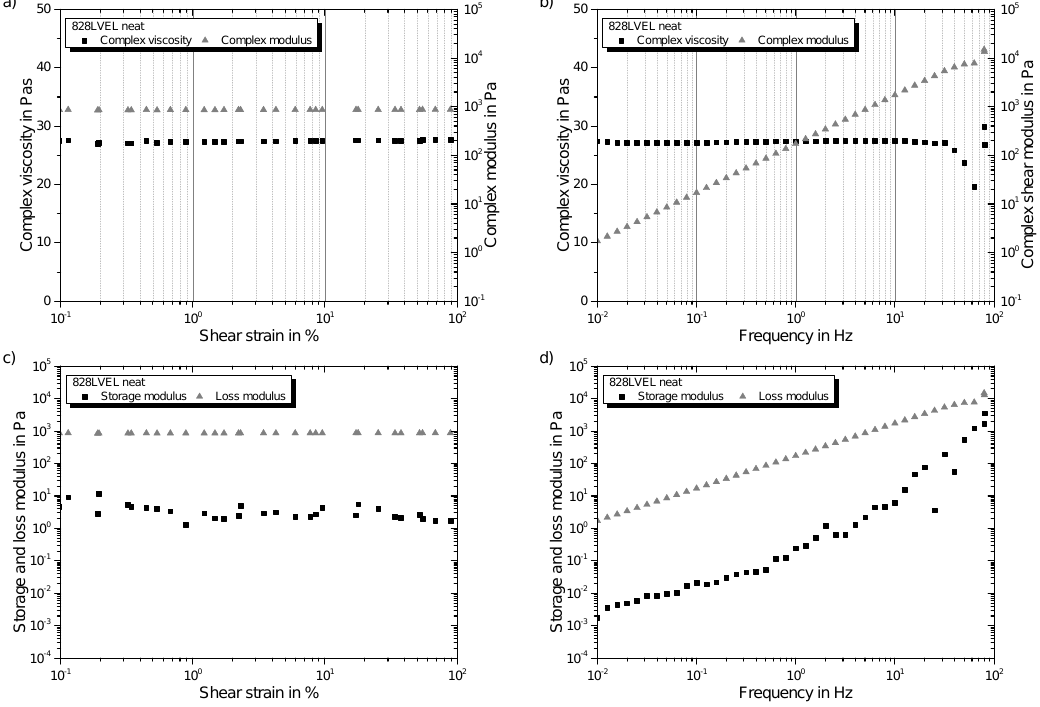
Figure 4. Oscillatory rheology results of 0.5wt% NC7000 in Epikote 828LVEL: ( a ) dependency of complex viscosity and complex modulus on shear strain ( f = 5Hz); ( b ) dependency of complex viscosity and complex modulus with increasing frequency ( γ 0 = 10%); ( c ) dependency of storage and loss modulus on shear strain ( f = 5Hz); ( d ) dependency of storage and loss modulus on frequency ( γ 0 = 10%).